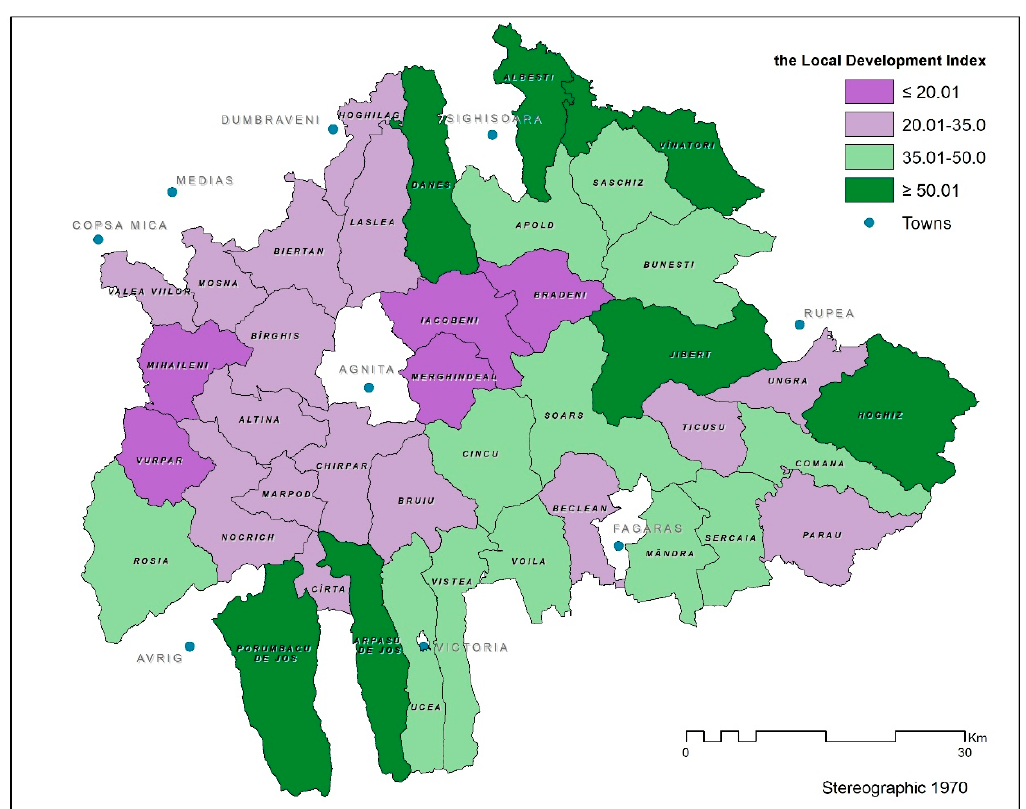
Figure 1. The distribution of the Local Development Index .